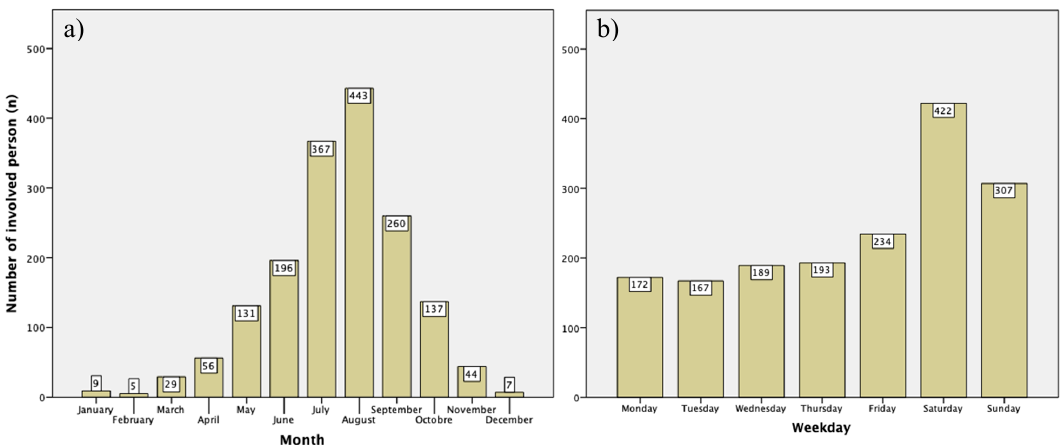
Figure 1. Months ( a ) and days of the week ( b ) of via ferrata emergencies in Austria from 1 November 2008 to 31 October 2018.